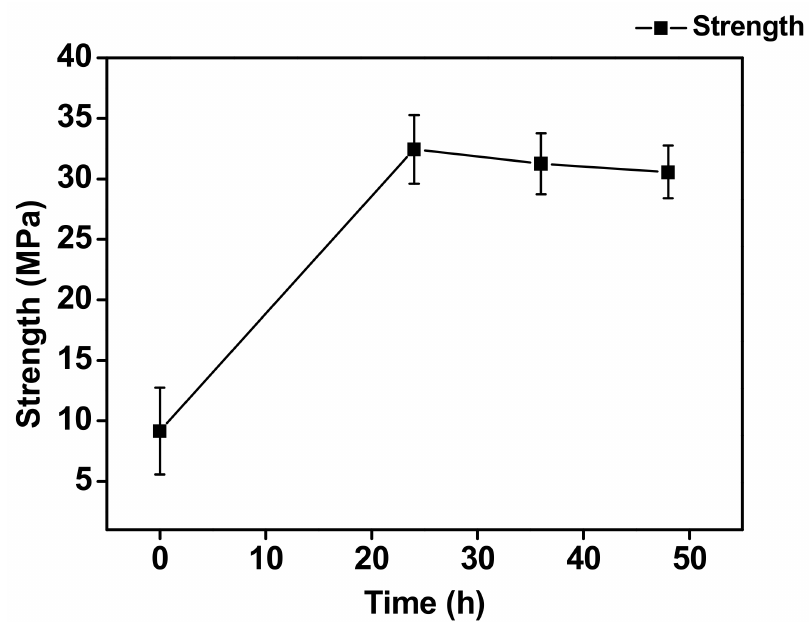
Figure 12. Variation of the shear strength with the aging time at 200 ◦ C.